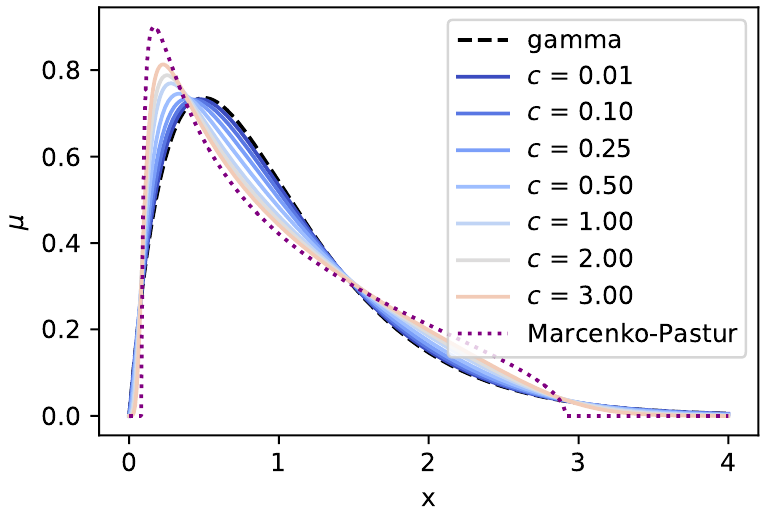
for different values of 2